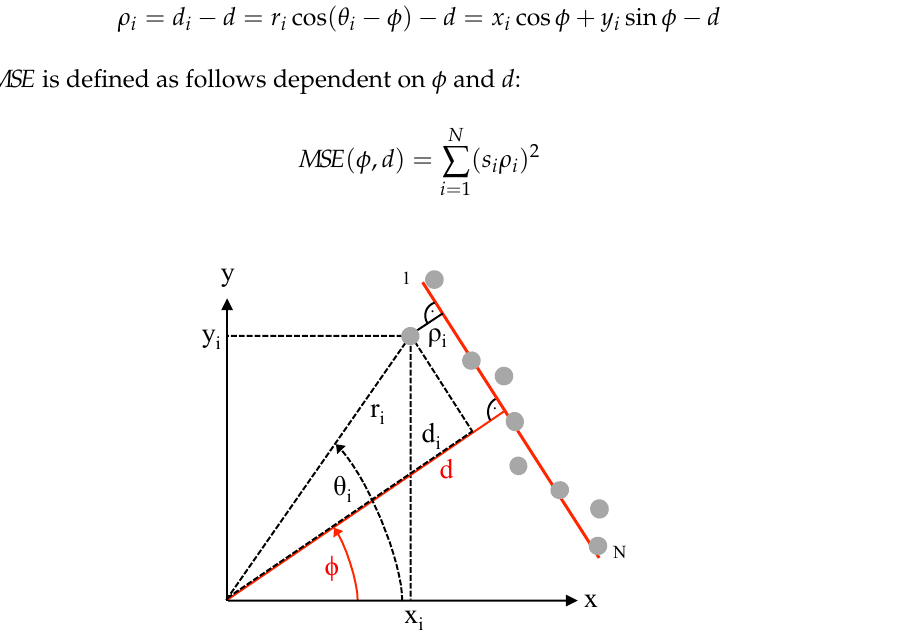
Figure 1. Parameters of measured raw data and a fitted straight